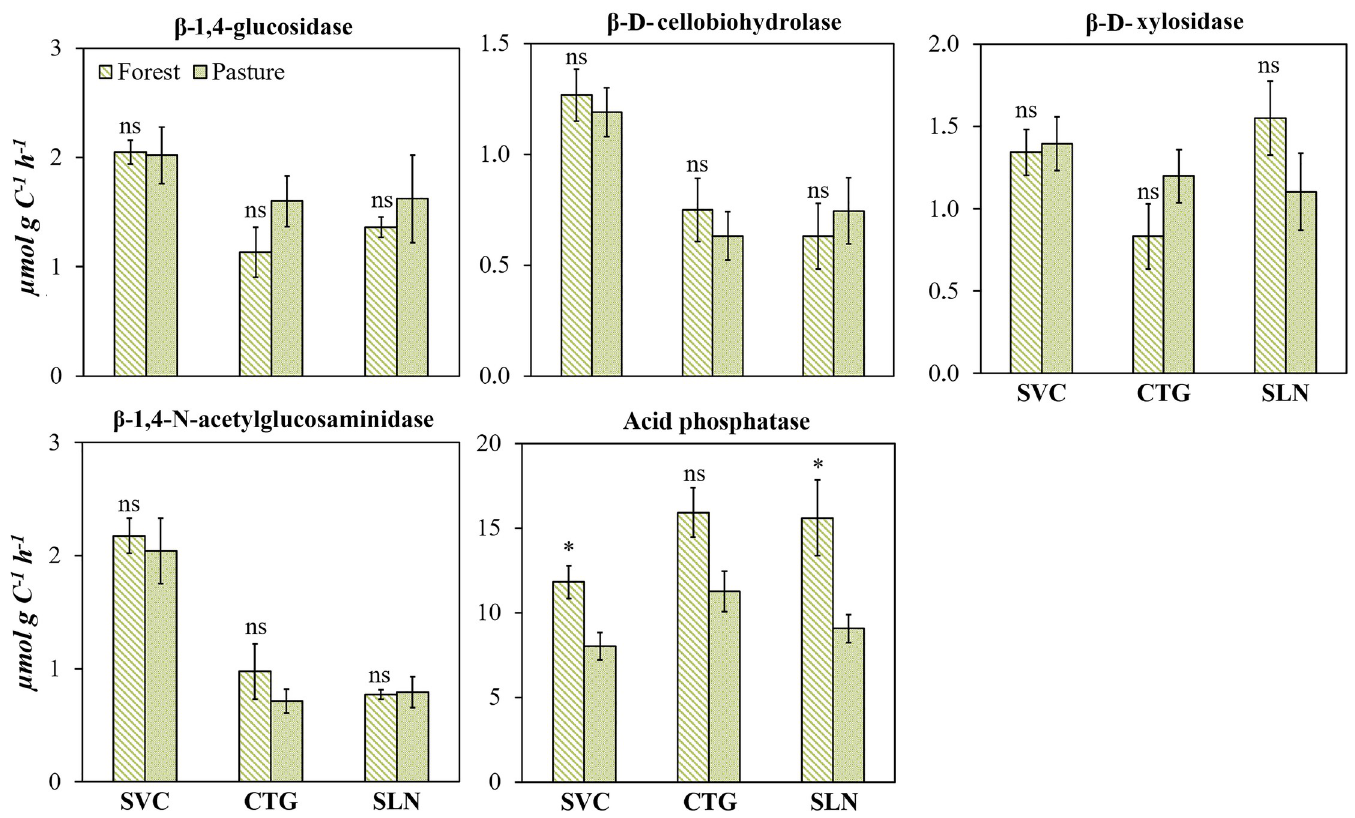
Fig 6. Specific activity per unit of SOC of soil enzymes β -Glucosidase, β -D-Celobiosidase, β -D-Xylosidase, N-acetyl- β -D-Glucosaminidase, acid phosphatase in pristine forest and pastures located in hills landscape (SVC: San Vicente del Caguan, CTG: Cartagena del Chaira, SLN: Solano) of Colombian Amazon region. Error bars denote error deviation. The asterisk indicates that the means values of soil and litter differ significantly between themselves ( p < 0.05) for each study site, according to the Student’s Test.